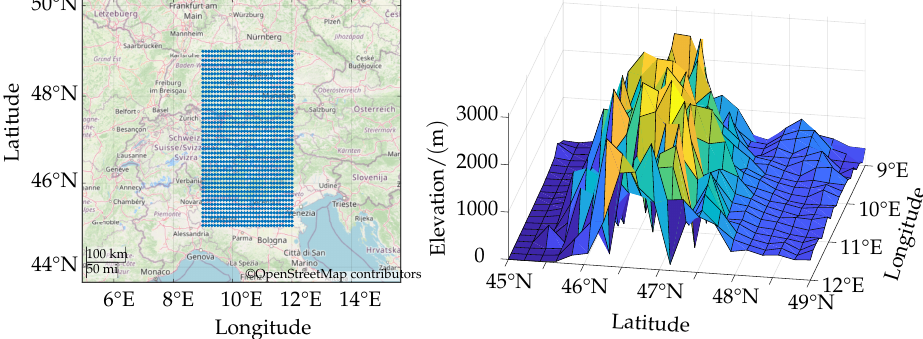
Figure 7. Visualisation of SRTM data points in Map (left) and corresponding elevation data (right)